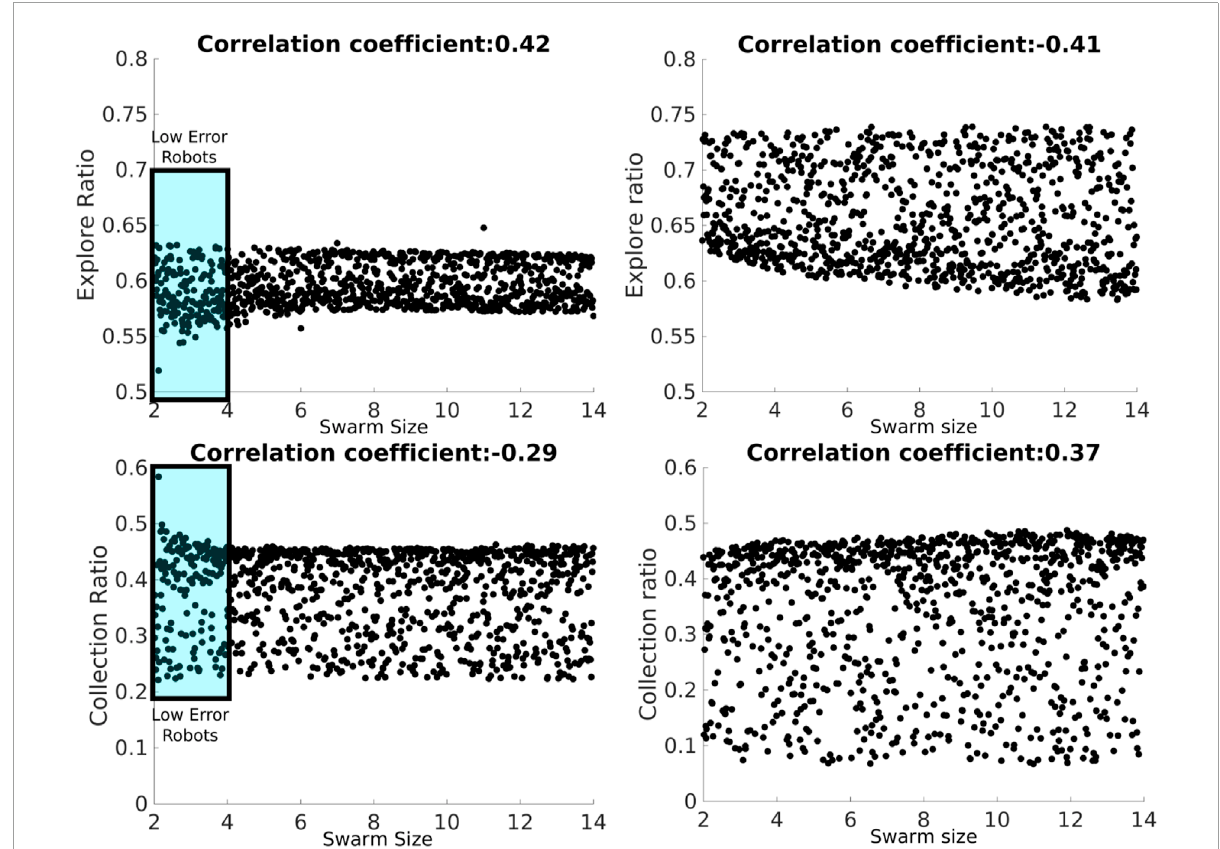
FIGURE 10 LHA for the d parameter for the DPS with heterogeneous (left column) and homogeneous (right column) errors and the explore ratio (top row) and collection ratio (bottom row) outputs. The blue rectangle represents the proportion of low-error robots.